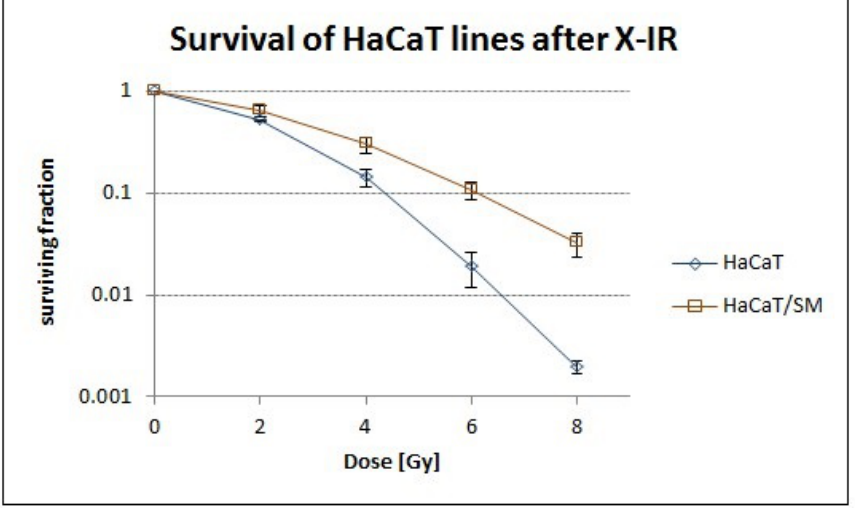
Figure 2. Survival of HaCaT after irradiation. Cellular survival after increasing doses of X-ray